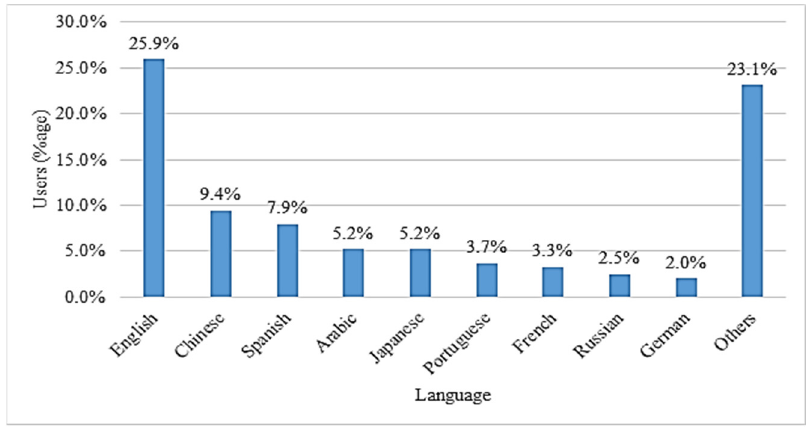
Figure 3. Internet user distribution by language [49].